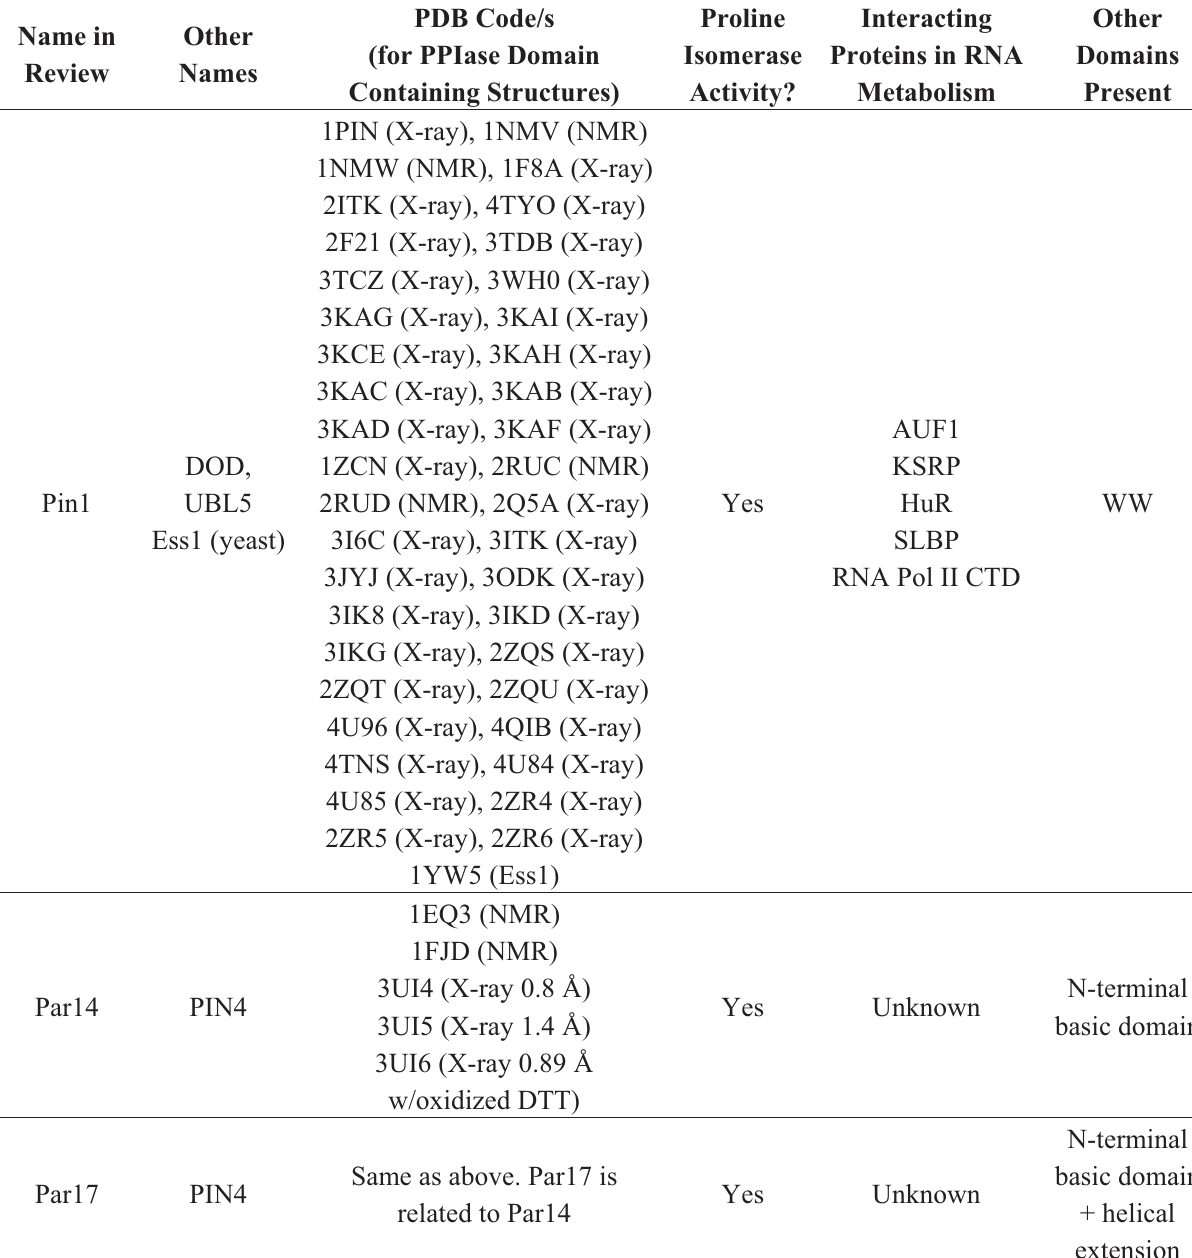
Table 3. Summary of parvulins involved in RNA-mediated gene